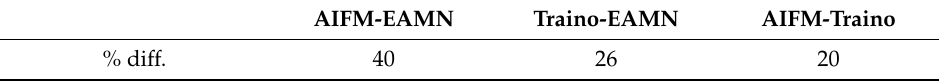
Table 5. Percentage di ff erence between di ff erent calculation